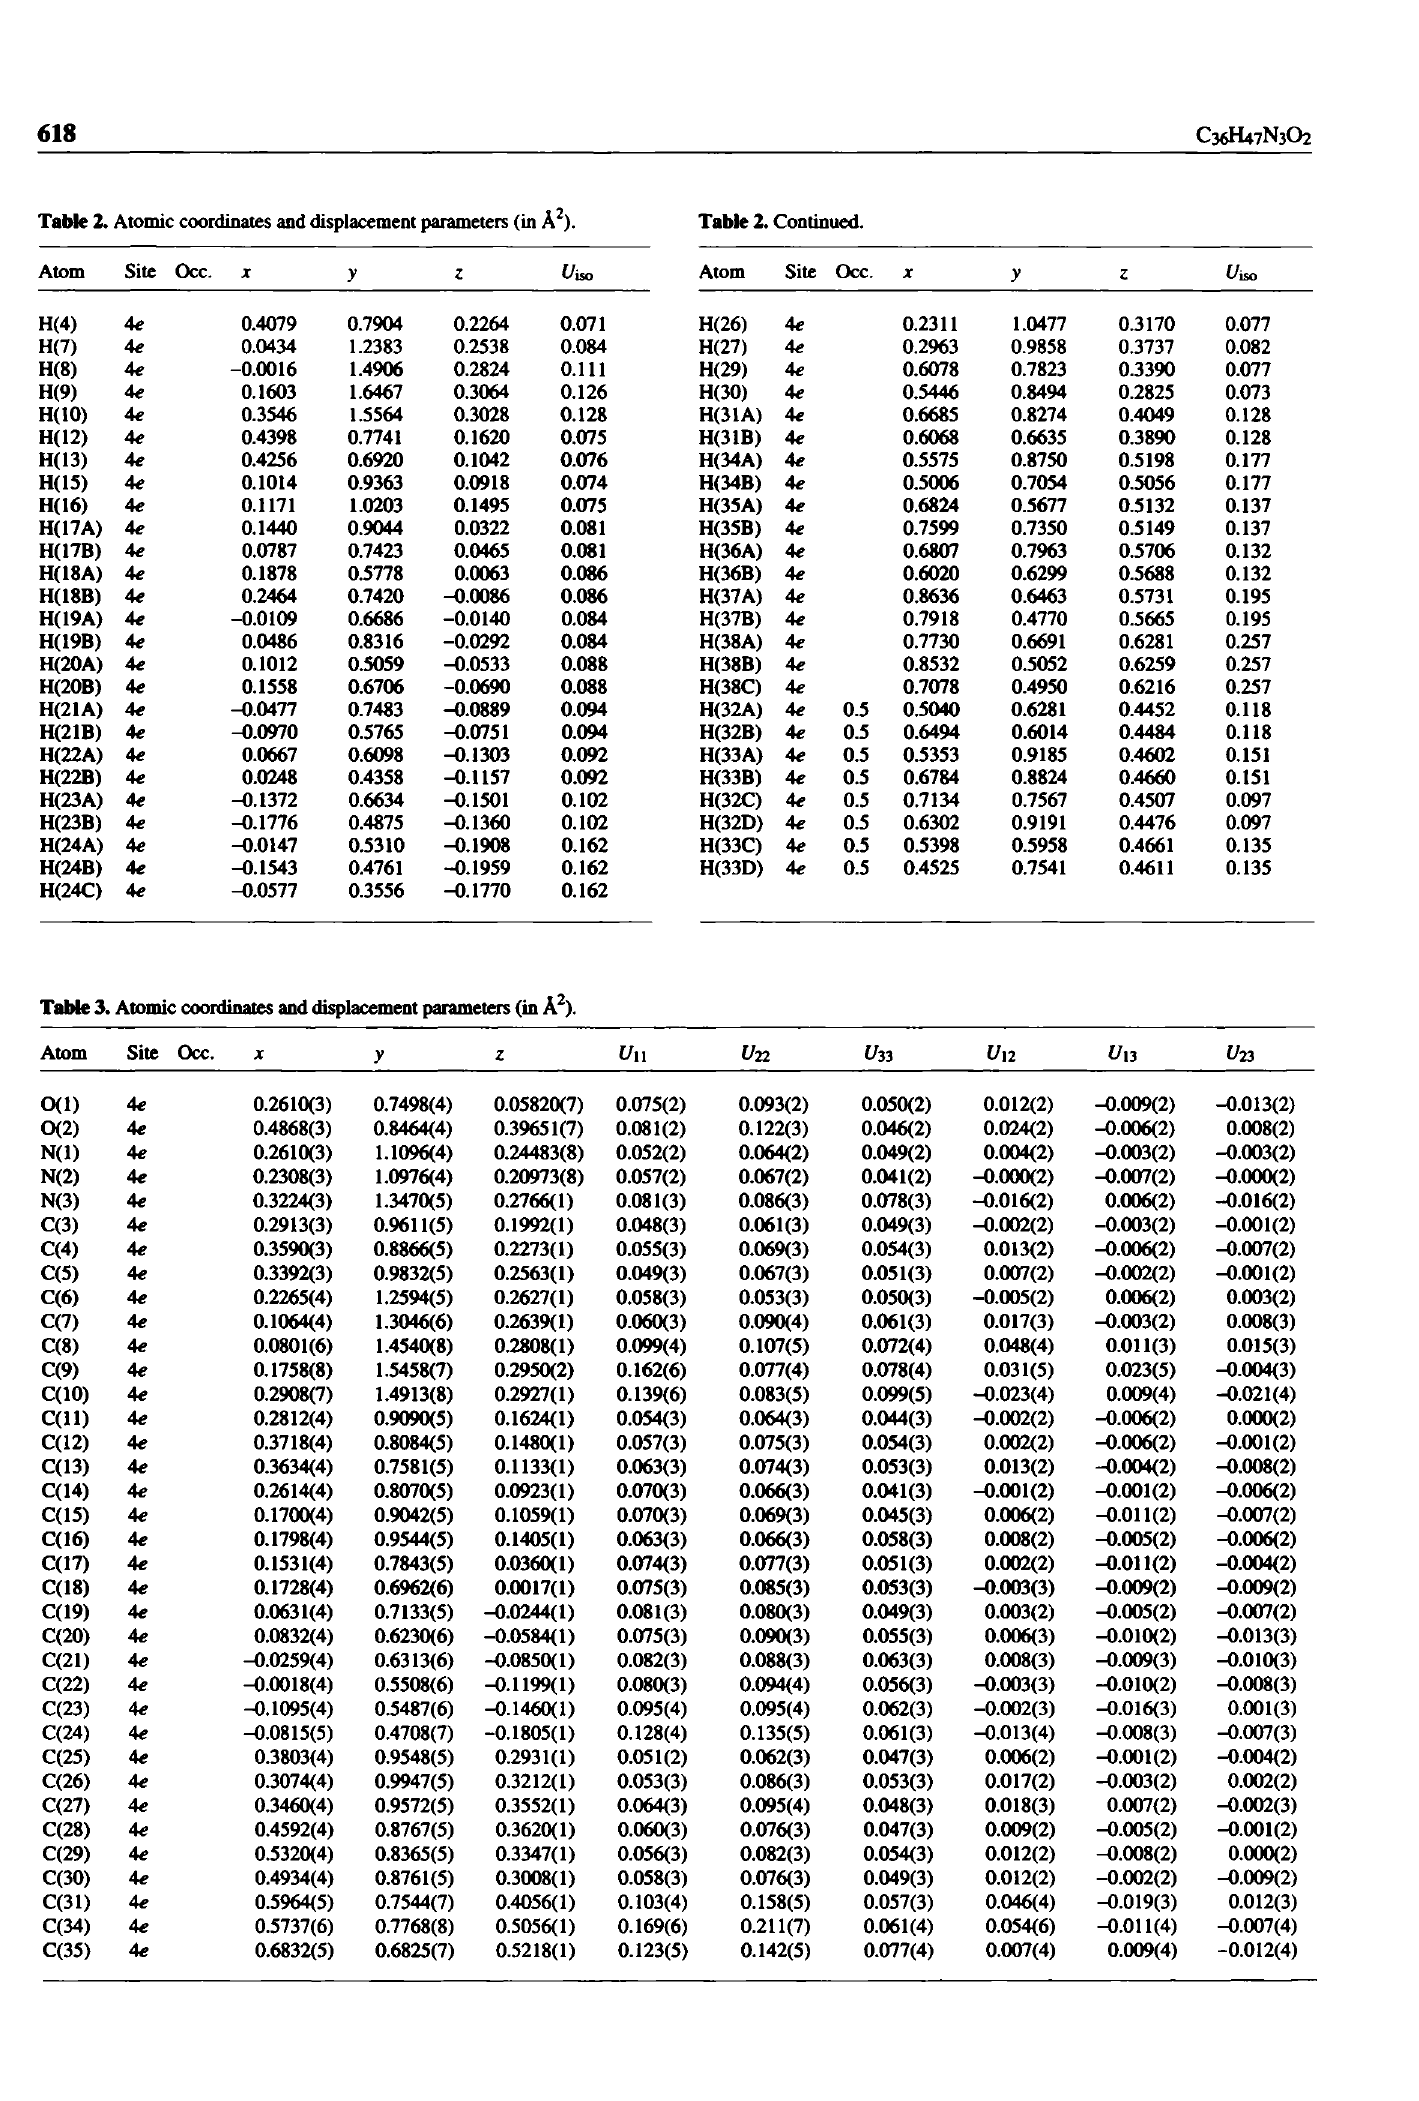
Table 3. Atomic coordinates and displacement parameters (in A 2